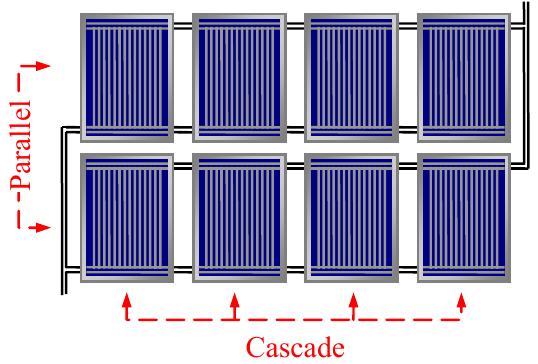
Figure 1. Typical forced circulation solar water